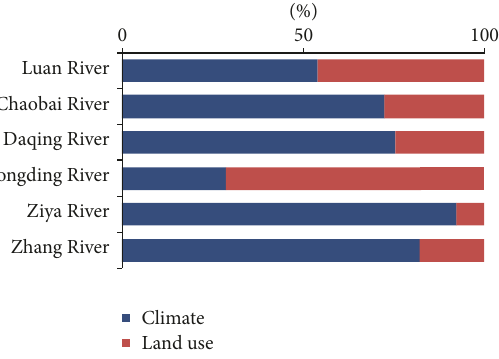
Figure 5: The contribution of climate and land-use changes to the variation in runoff in the six subbasins in the period of 1980–2010. The statistical significance was < 0.01 in Luan River Basin (LRB), Chaobai River Basin (CRB), Yongding River Basin (YRB), and Daqing River Basin (DRB); while it was < 0.1 in Ziya River Basin (ZRB) and Zhang River Basin (ZhRB).